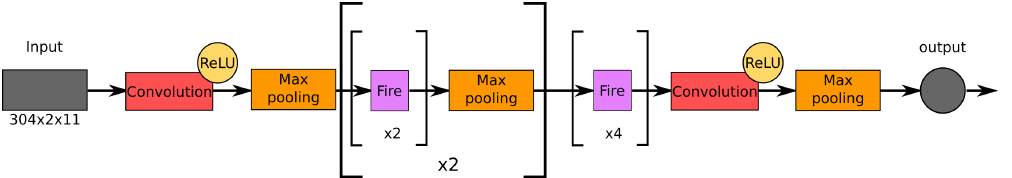
Figure 8. Architecture of SqueezeNet used as a baseline